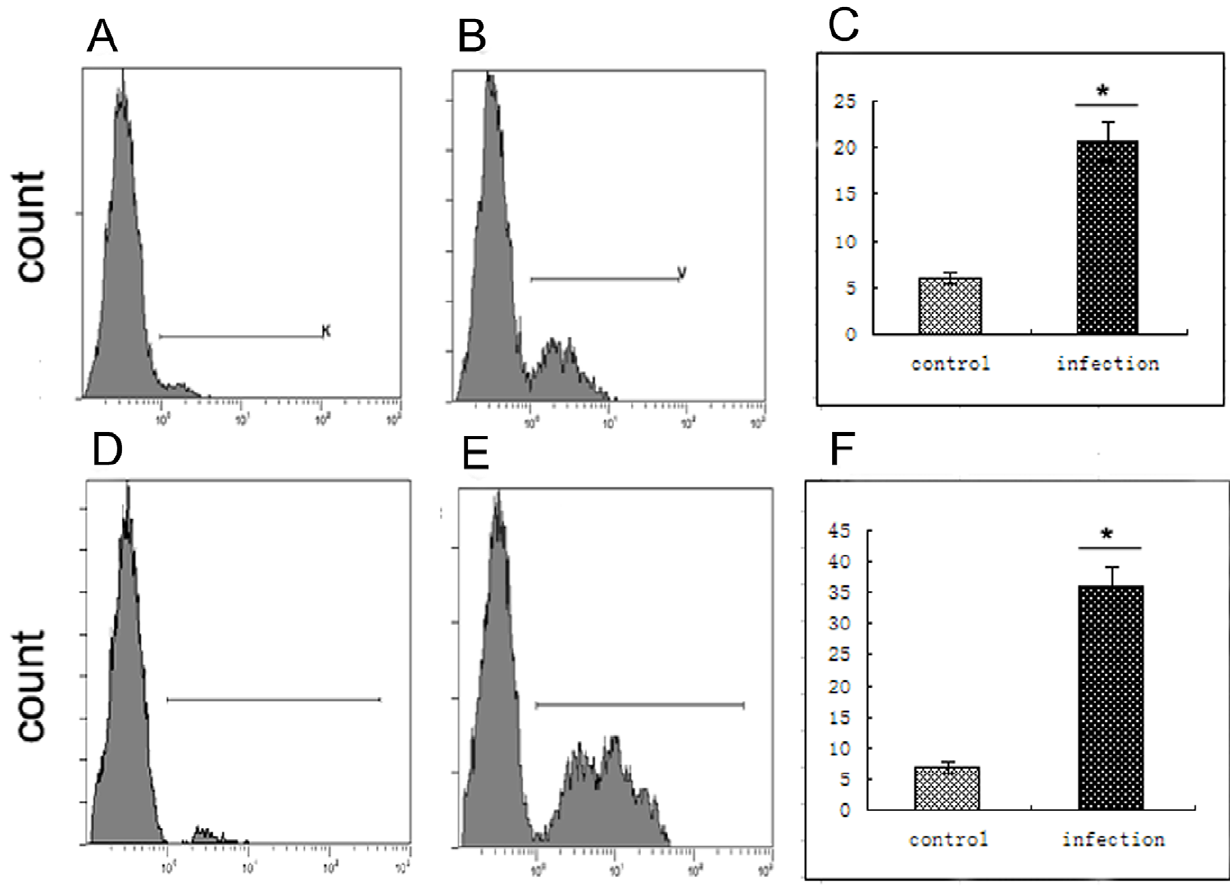
Figure 5. Levels of NKG2A and NKG2D in mice following T.gondii infection. Levels of NKG2A and NKG2D on dNK cells is altered by infection of mice with T. gondii . At 6 days post infection, the expression levels of NKG2A and NKG2D on the surface of uninfected (A, D) and infected (B, E) uterine and placental cells were analyzed by flow cytometry. (C, F) Data are presented as the means 6 SEM (n=15, * p , 0.05).